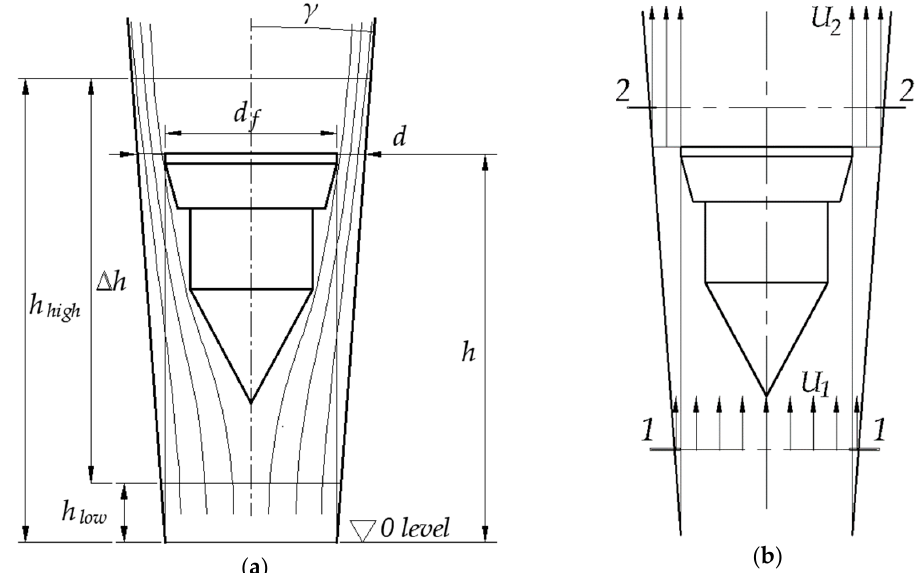
Figure 1. ( a ) Simplified geometry of a variable area flowmeter and the streamlines across it (not to scale); ( b ) Section 1.1. is where the float does not yet influence the flow. Section 2.2. is in the narrowest annular stream section, “vena contracta”. All of the marked heights are measured from the zero level. The zero level is the height at which diameter of the tube d is equal to the float diameter d f .